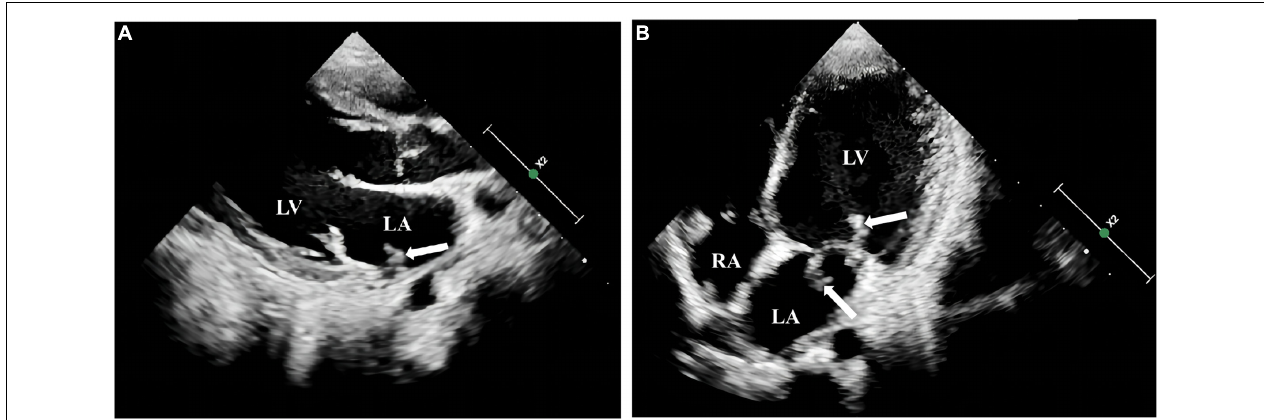
FIGURE 2 | Transthoracic echocardiography examination of the heart in the pediatric patient. A striated flocculent hyperechoic attachment (A) , was observed at the entrance to the left pulmonary vein in the lateral posterior wall of the left atrium, with thickened anterior and posterior mitral leaflets and a striated flocculent hyperechoic attachment with a floppy texture visible in both anterior and posterior leaflets (B) . LA: left atrium; LV left ventricle; RA: right atrium.